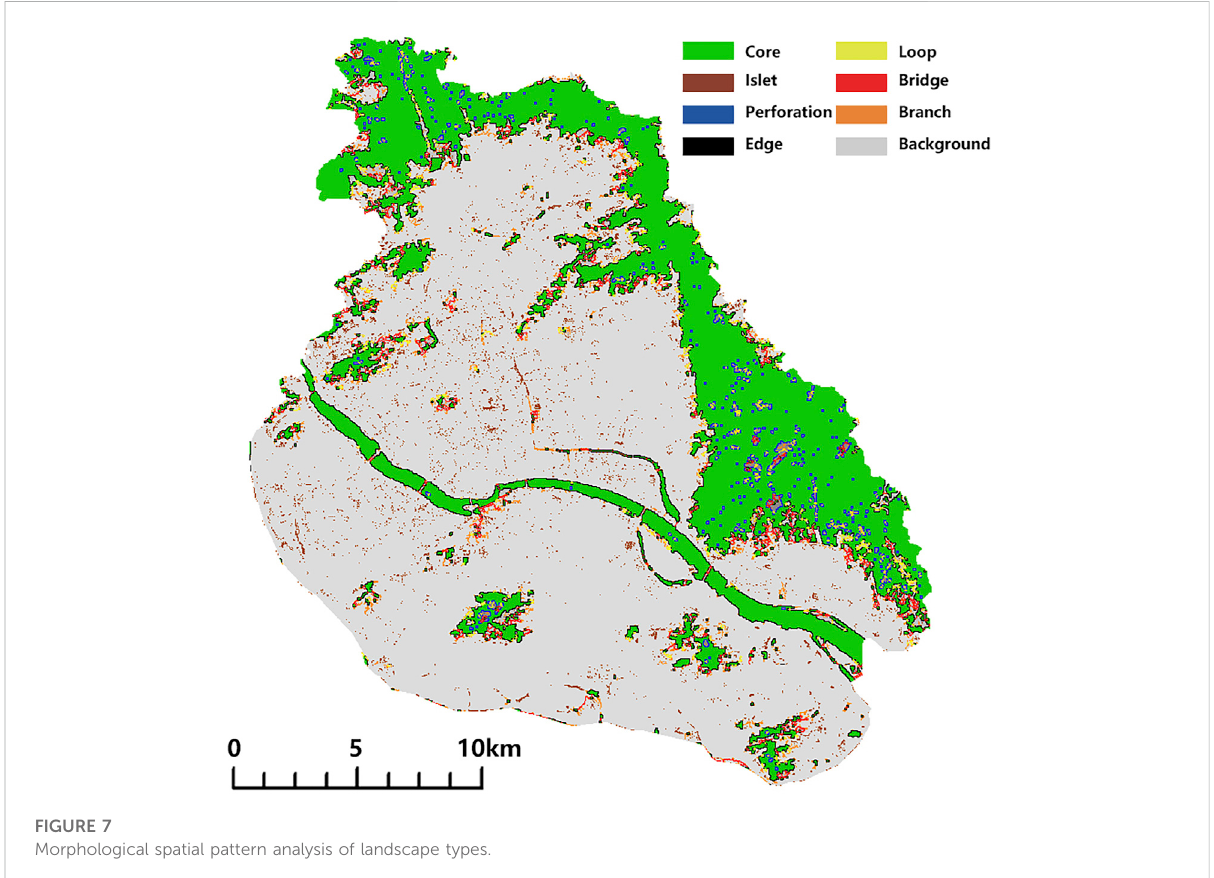
FIGURE 7 Morphological spatial pattern analysis of landscape types.